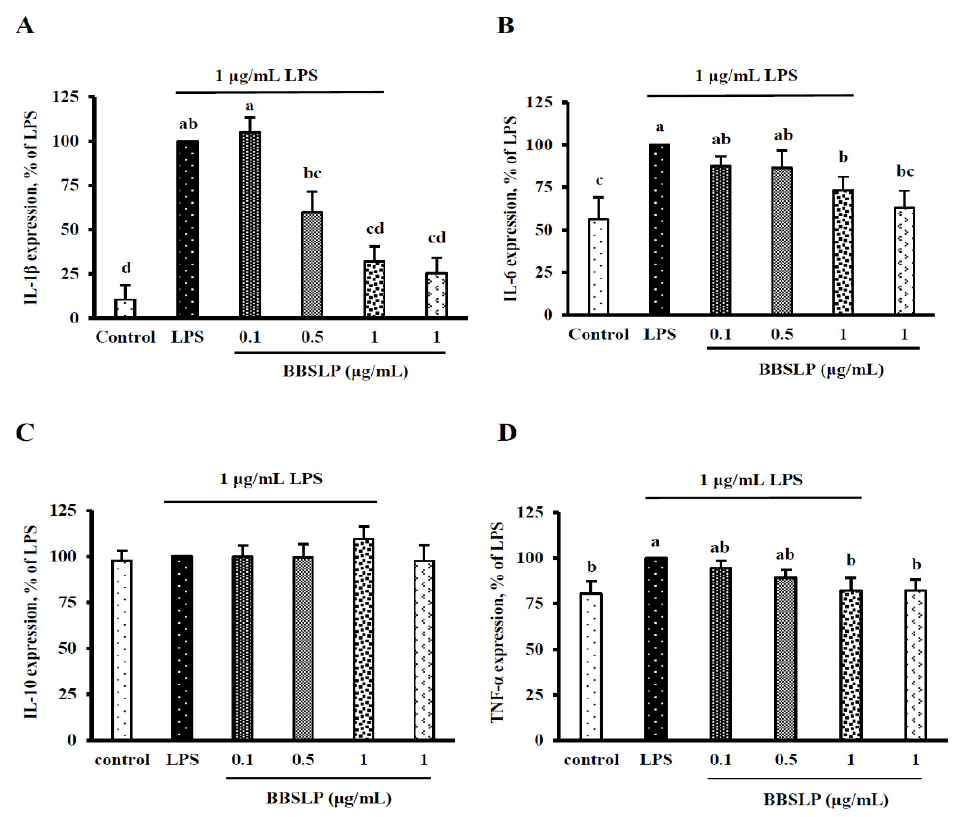
Figure 5. Effects of BBSLP on the inflammatory response in RAW264.7 cells induced by LPS. RAW264.7 cells (1 × 10 5 cells/30-mm plate) were seeded and cultured overnight, treated with 0.1, 0.5 or 1 μ g/mL BBSLP for 24 h and then induced or not with 1 μ g/mL LPS for another 24 h. The group